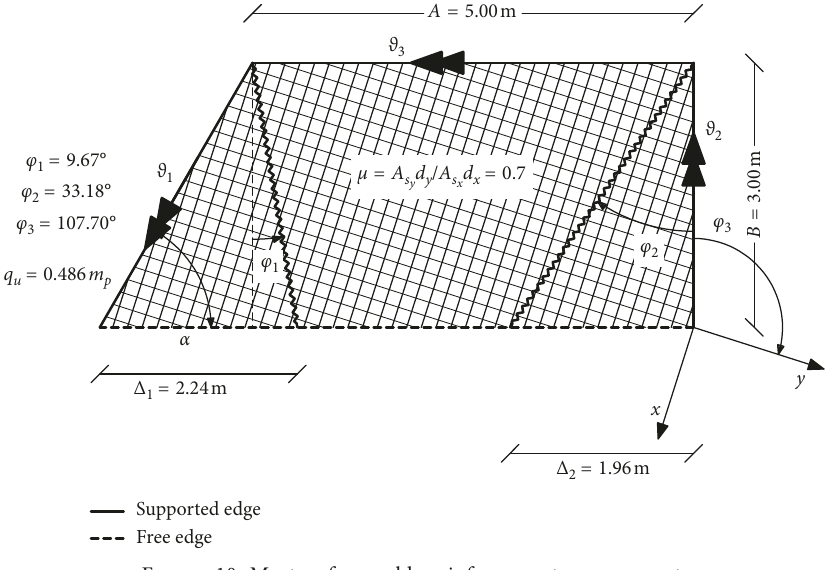
Figure 10: Most unfavourable reinforcement